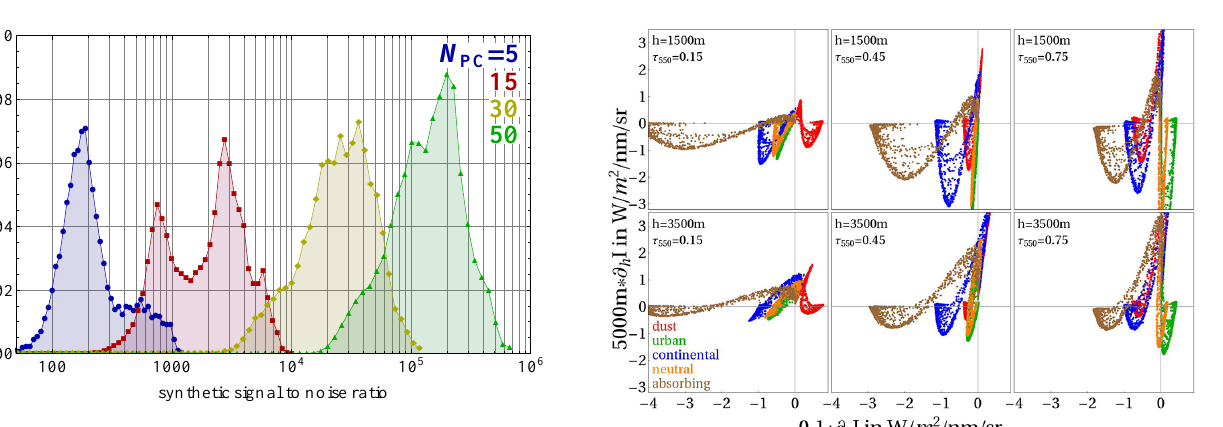
Figure 4. Histograms of the synthetic SNR for selected values of n p . Note that the abscissa is in log scale and that occurrence bins were chosen to be equally spaced in a log plot. Figure 5. Phase functions at 774 . 5nm of the five used aerosol mod- els.